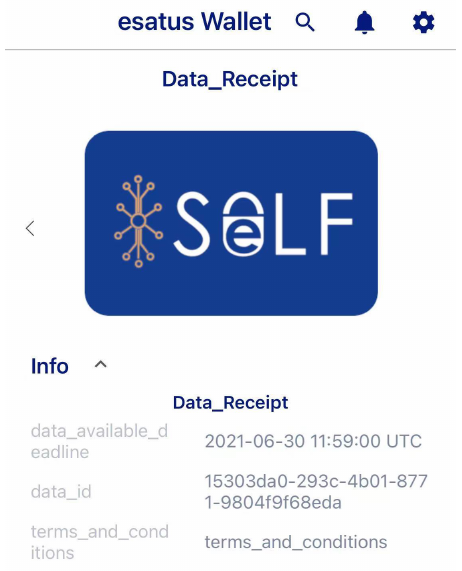
Fig. 10. The license receipt